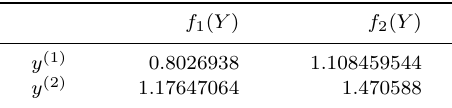
Table 2. Pay-off matrix to find bounds of (cid:15)